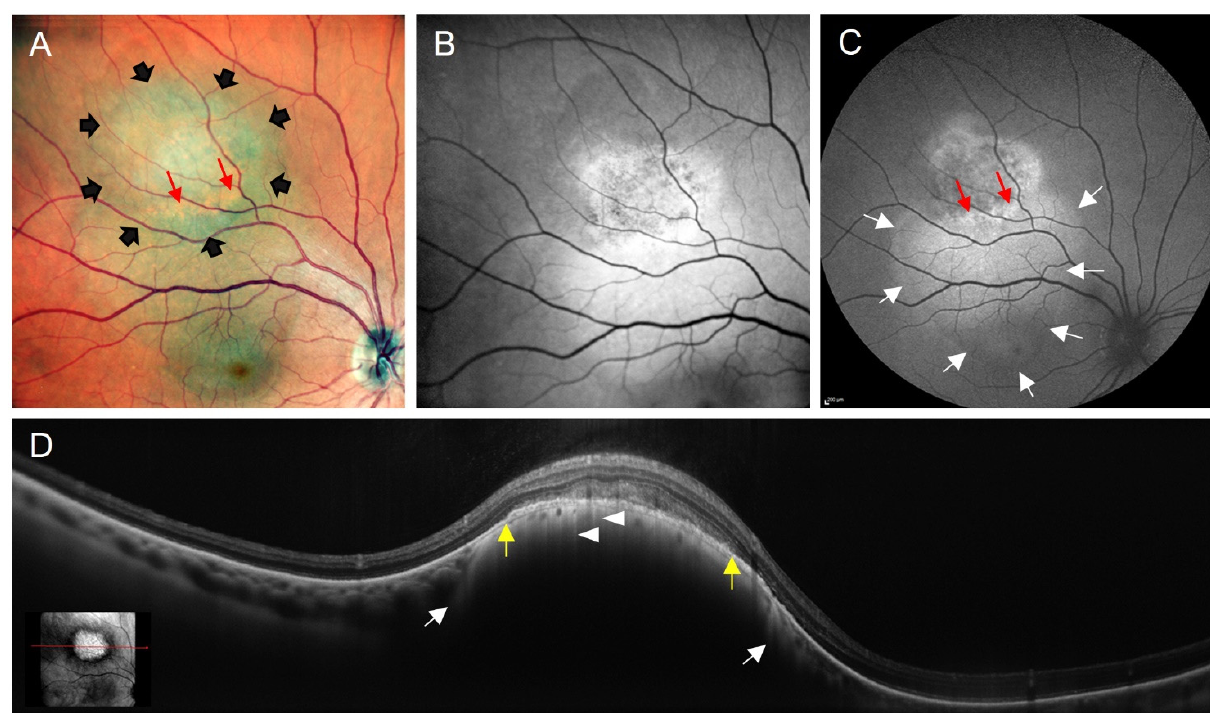
Figure 2. Multimodal imaging of a choroidal melanoma in a 58-year-old Caucasian male. ( A ) Fundus photography. Composite of three separate red/green/blue detectors simultaneously scanning different depths of the retina with red, green, and blue wavelengths, showing choroidal melanoma in the midperiphery (delineated by black arrowheads). Orange pigment (red arrows) can clearly be seen on top of the tumour mass. ( B , C ) Fundus autofluorescence images from different devices, both using 488 nm for excitation. The tumour has areas with increased and decreased autofluorescence. Orange pigment (red arrows) presents with brightly increased autofluorescence. Subretinal fluid—as an additional clinical sign of malignancy—has led to an area with increased autofluorescence (delineated by white arrows) adjacent to the tumour and involving the fovea. ( D ) SD-OCT scan through the choroidal melanoma (see inlet for exact location of the scan) shows the prominent tumour mass with compression of the choriocapillaris (between the two white arrows). In addition, the retinal pigment epithelium overlying the tumour (between the yellow arrowheads) is elevated from Bruch’s membrane. Tiny areas of RPE layer thinning or atrophy led to hypertransmission of the OCT signal (white arrowheads). Images were taken using: ( A , B , D ) the Mirante SLO/OCT (Nidek, Gamagori, Japan) and ( C ) the SPECTRALIS HRA (Heidelberg Engineering, Heidelberg, Germany)